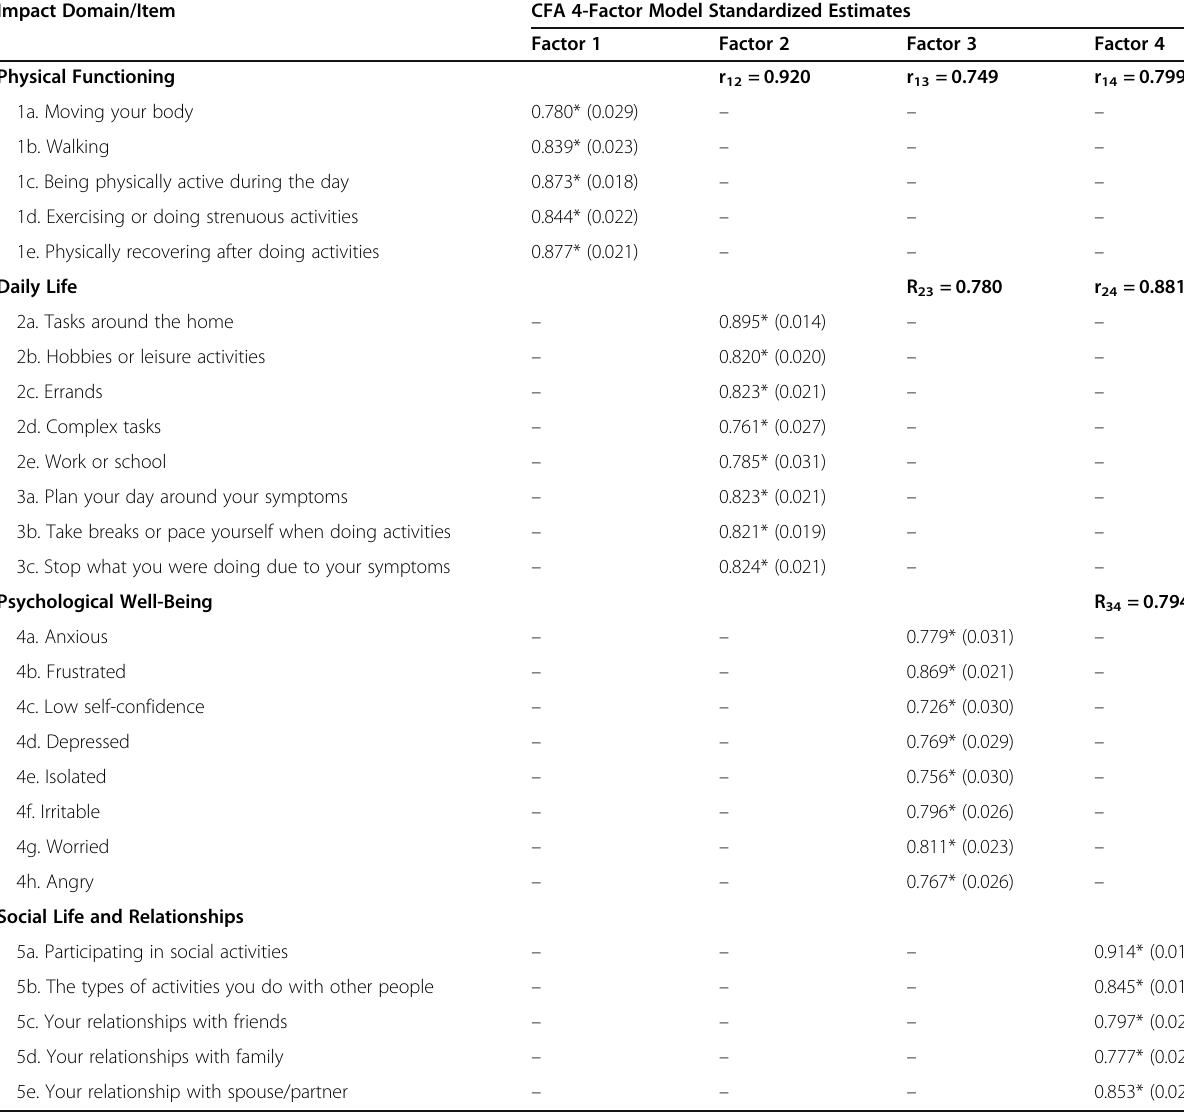
Table 6 CFA four-factor model — factor loadings (SEs) and fit indices for HPES-Impact using observational study data Impact